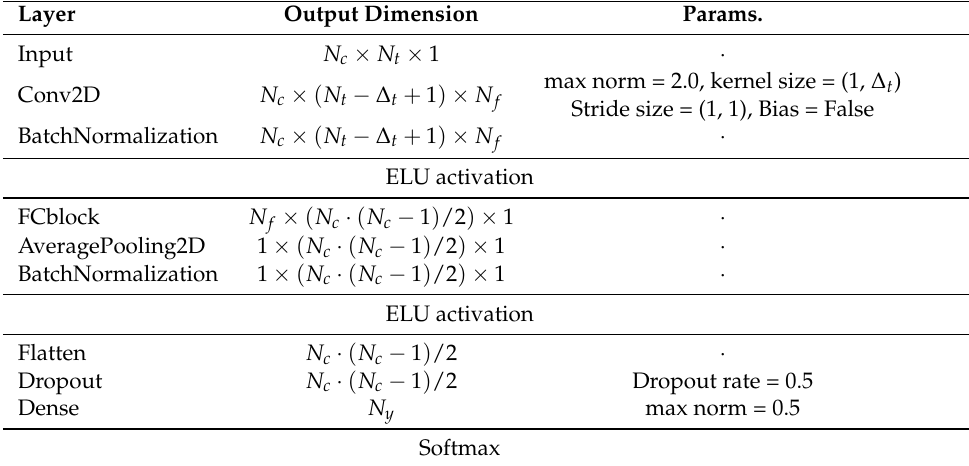
Table 1. Detailed KCS-FCnet architecture for MI